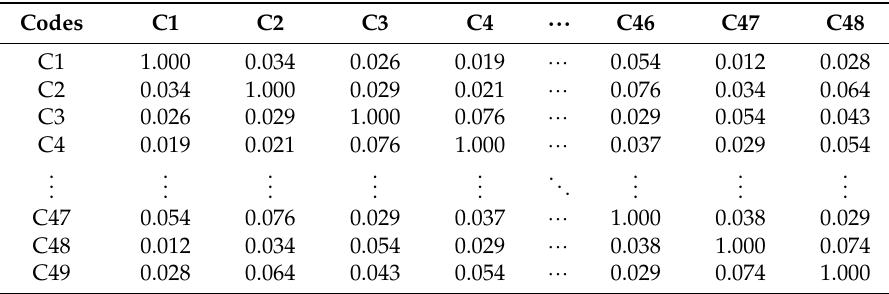
Table 8. The correlation coefficient of indicators.